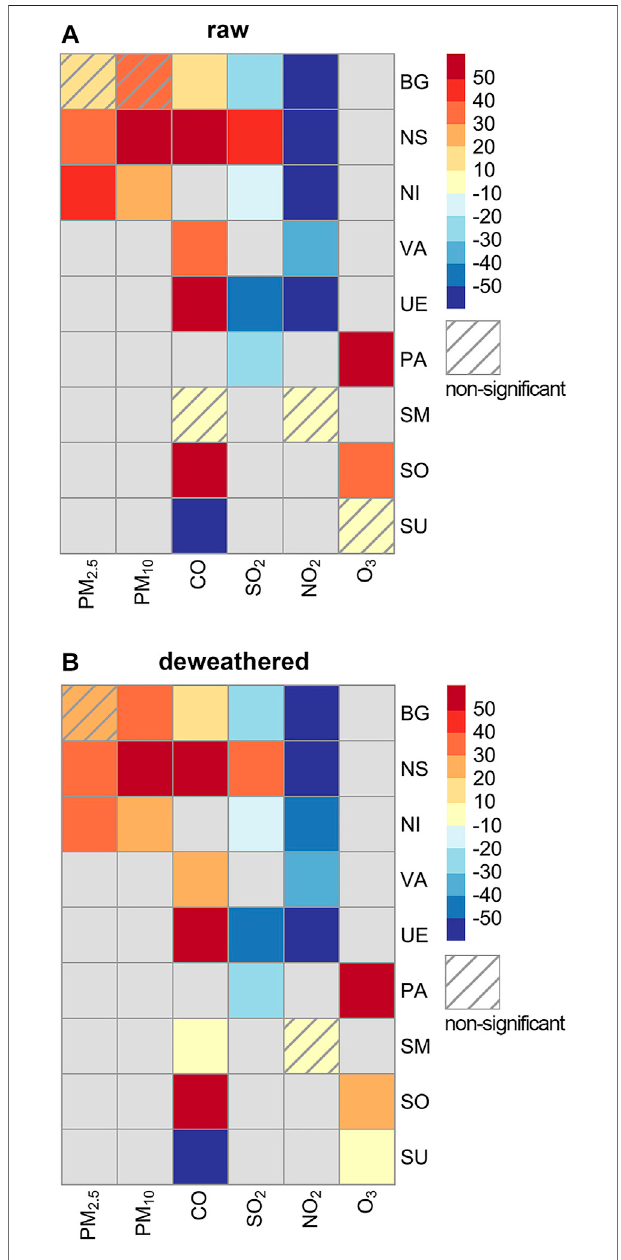
FIGURE 6 | Percentage of variations in raw (A) and “ deweathered ” (B) pollutant levels in each city under the study between 2020 and average concentrations in the period 2015 –